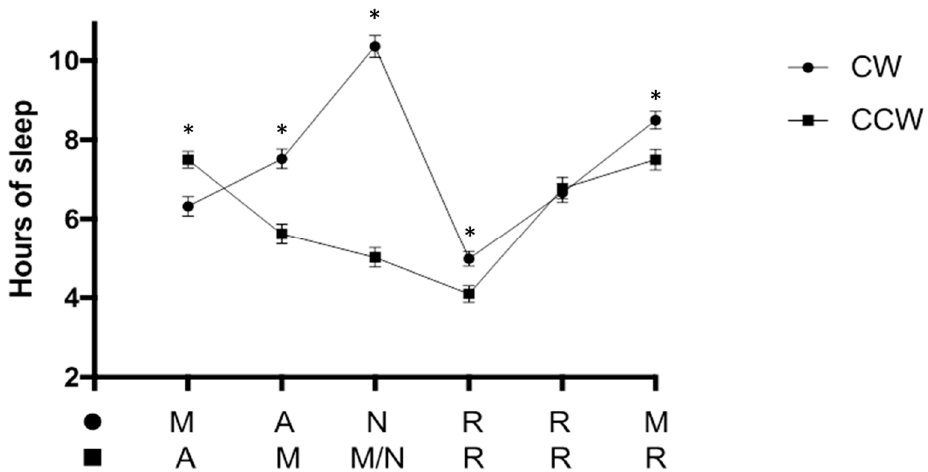
Figure 2. Hours of sleep in the 24 h before each shift or rest days. Note that the CW (clockwise) rotating nurses slept an average of 10 h before the night shift. The CCW (counterclockwise) rotating nurses had a morning shift and a night shift on the 3rd day of the shift cycle and slept an average of 5 h in the 24 h preceding the night shift. Of interest, both the CW and CCW rotating nurses slept the lowest number of hours following the night shift (5 h and 4 h, respectively). M: morning shift (6 a.m.–2 p.m.); A: afternoon shift (2 p.m.–10 p.m.); N: Night shift (10 p.m.–6 a.m.); R: Rest days; M/N: indicates where CCW nurses worked both morning and night shift on the same day; * p < 0.05 CW vs. CCW.